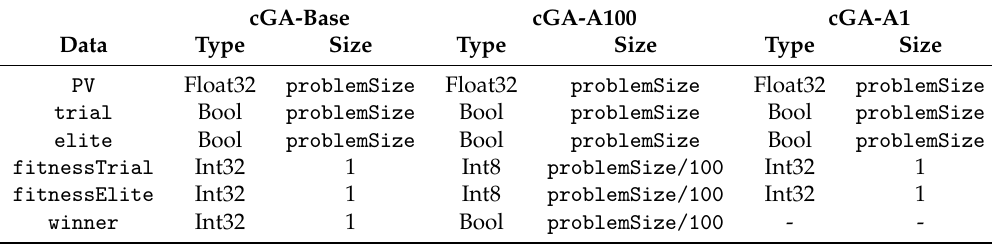
Table 2. Data type and size for the binary